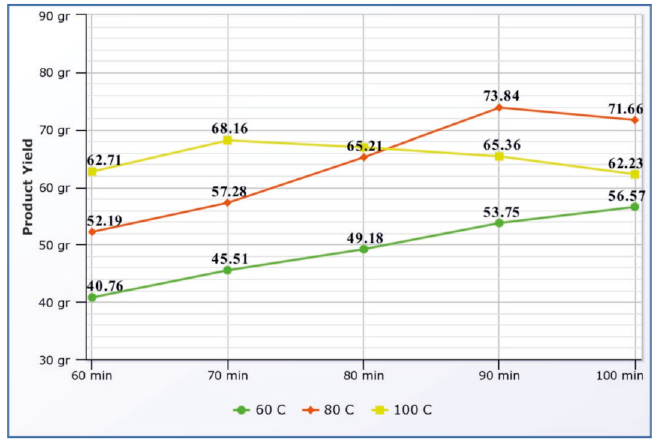
Figure 6. Influence of temperature and time on product